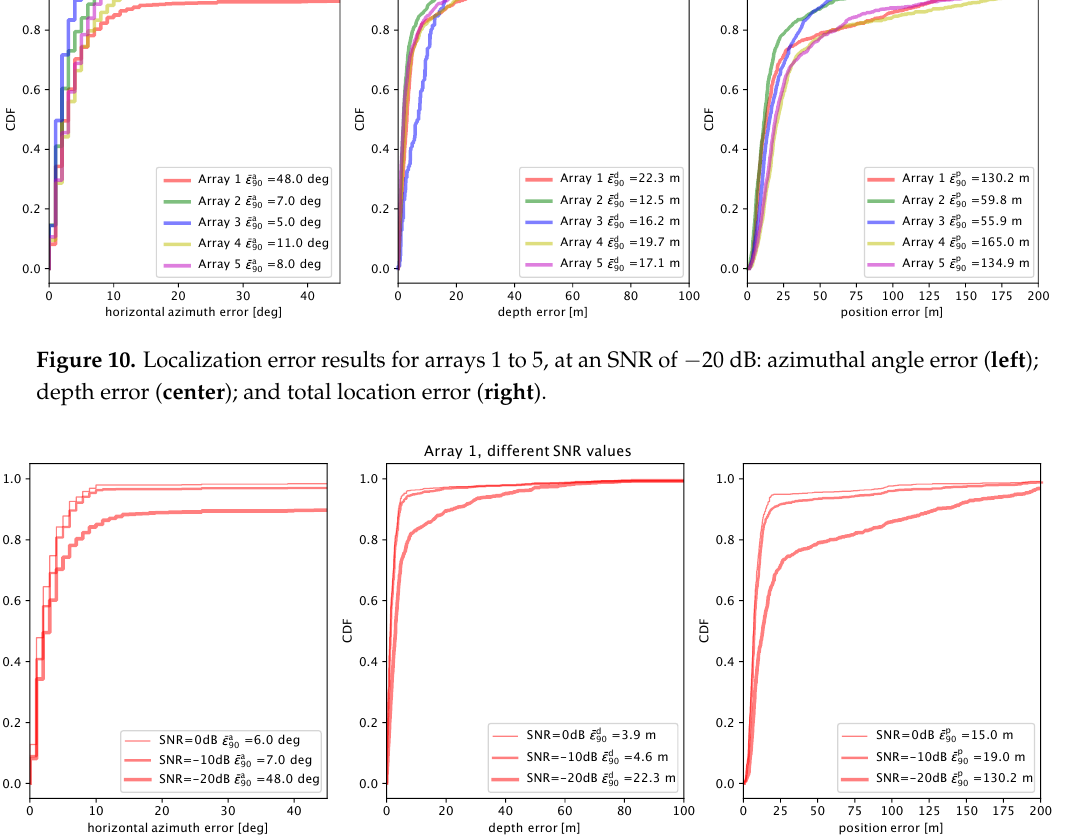
Figure 11. Localization error results for array 1 at different SNRs of 0, − 10 and − 20 dB: azimuthal angle error ( left ); depth error ( center ); and total location error ( right ).